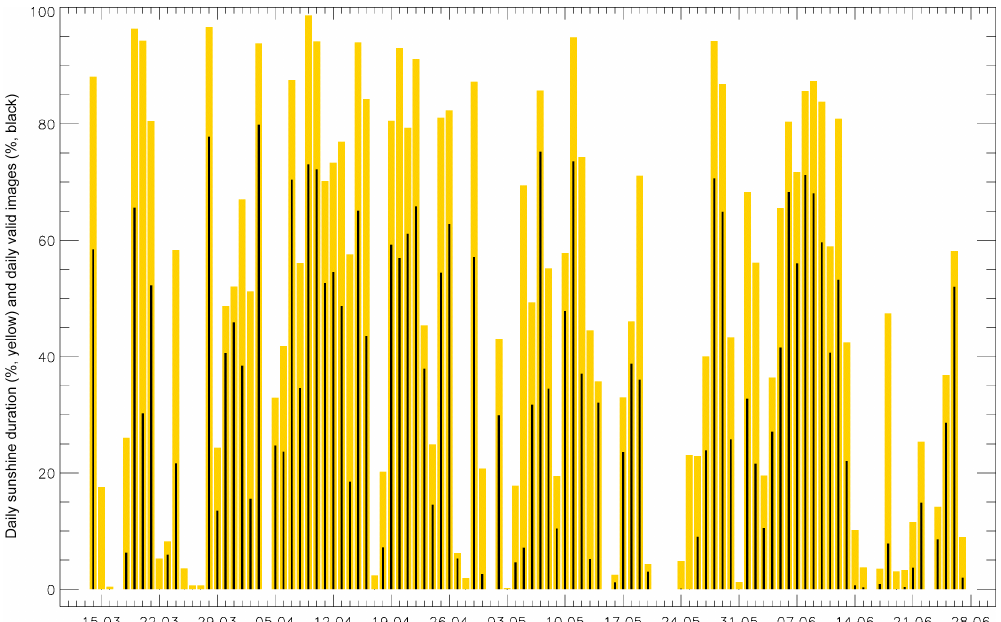
Figure 5. Relative daily sunshine duration (yellow) and valid KSO-STREAMS results (black) during the evaluation period from 14 March to 27 June